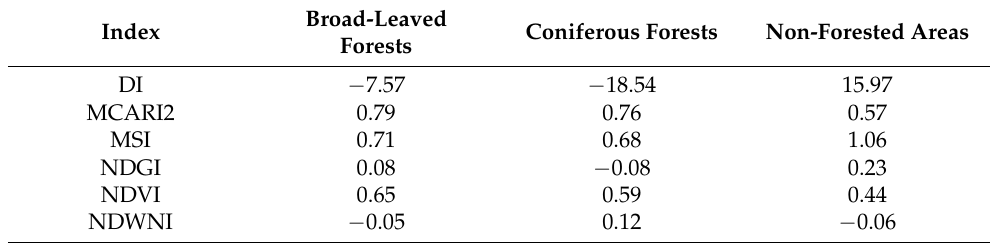
Table 4. Mean values of the spectral indices in broad-leaved forests, coniferous forests, and in non-forested areas in 2018.